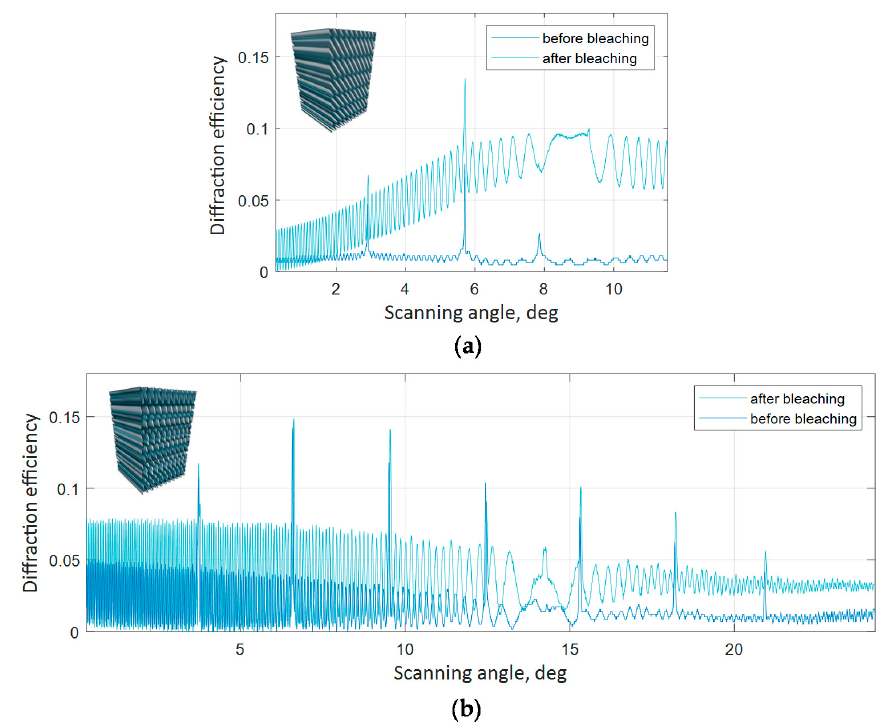
Figure 4. Measurements of the di ff raction e ffi ciency via exposition dose of multiplexed grating: ( a ) Recorded by Bragg phase mask with five exposures; and ( b ) relief phase mask with seven